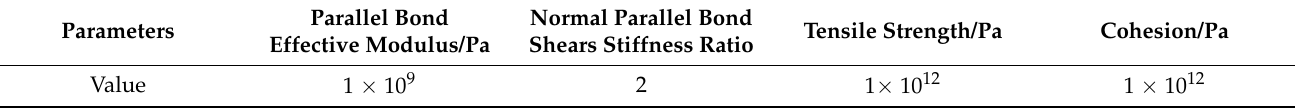
Table 3. Bonding parameters for fiber-fiber contacts